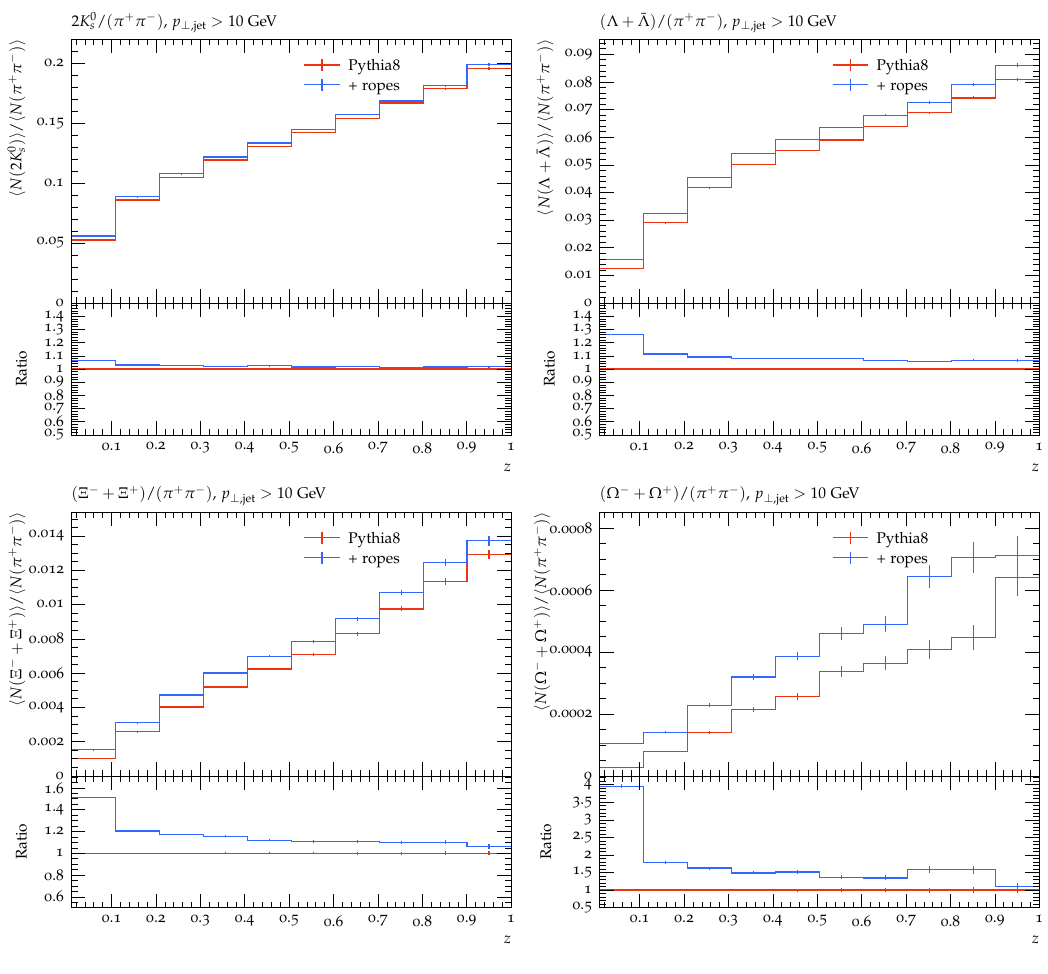
/ p ⊥ ,jet for pp collisions at ,particle